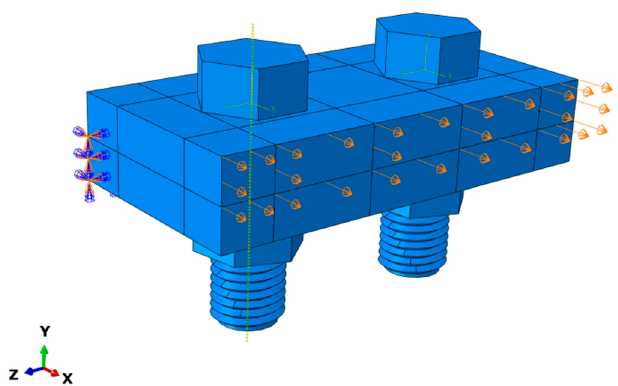
Figure 7. Local model loading diagram.